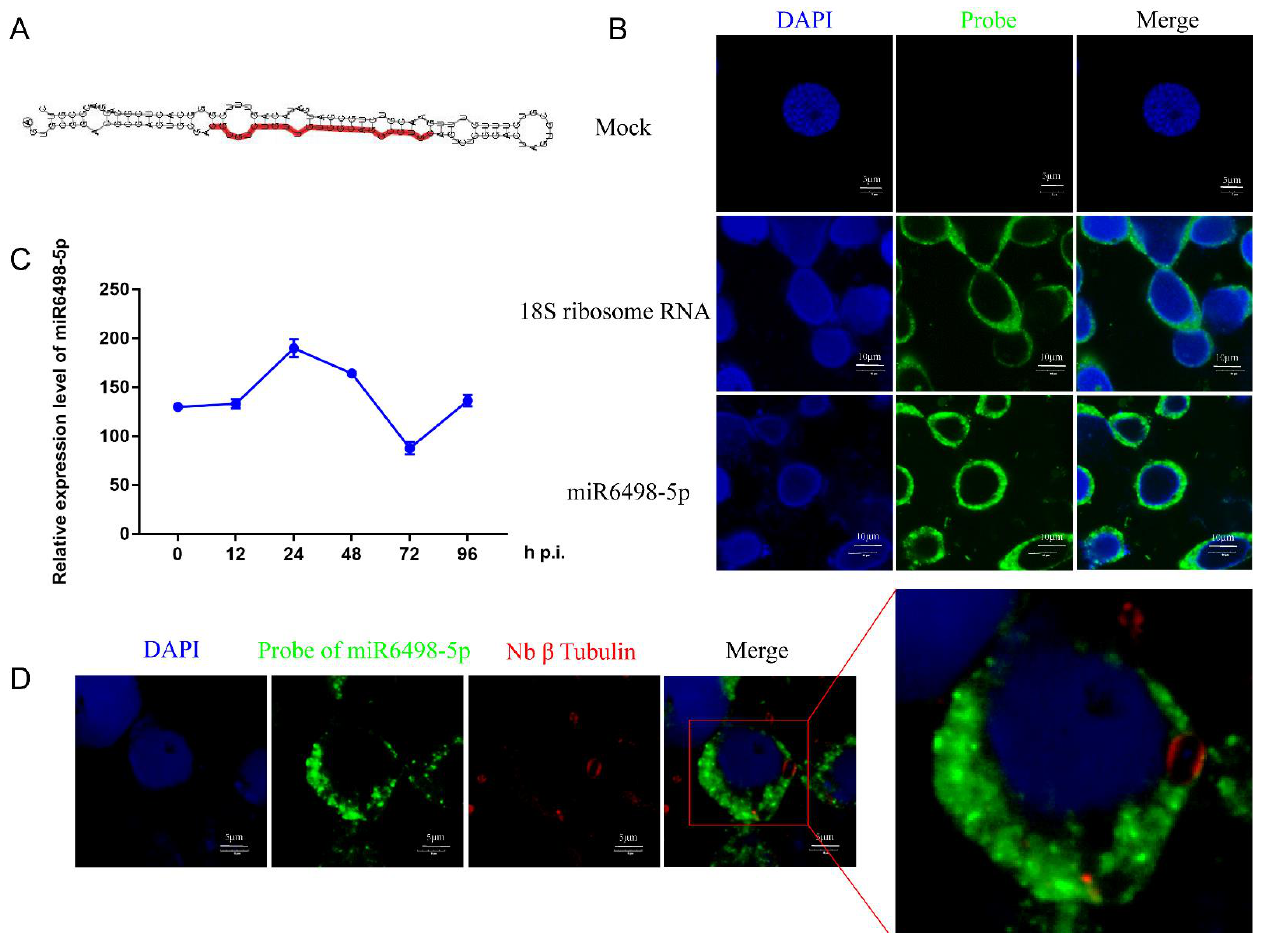
Figure 4. Characterization of miR6498-5p in BmE cells ( A ) Precursor structure of miR6498-5p. The red color represents the location and sequence of miR6498-5p. ( B ) Fluorescence in situ hybridization (FISH) of miR6498-5p and B. mori 18S RNA. The DAPI staining represents the nuclei and green fluorescence represents the location of miR6498-5p or 18S ribosomal RNA. ( C ) Alteration of the expression level of miR6498-5p with the infection of N. bombycis at different time points. ( D ) The location of miR6498-5p in BmE cells infected by N. bombycis . The green fluorescence represents the location of miR6498-5p, and the red fluorescence represents the locations of